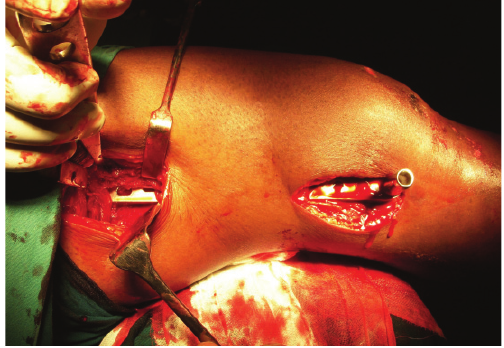
Figure 2: Fracture distal femur being fixed with DCS by MIPO.